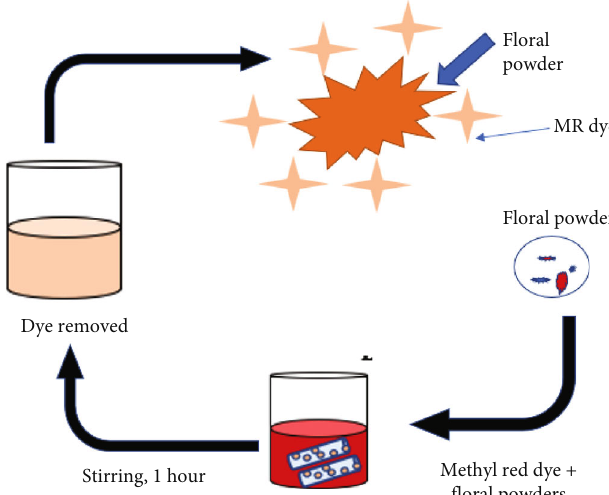
Figure 4: Steps involved in the fl oral waste based biosorbent development and dye removal from aqueous solutions.